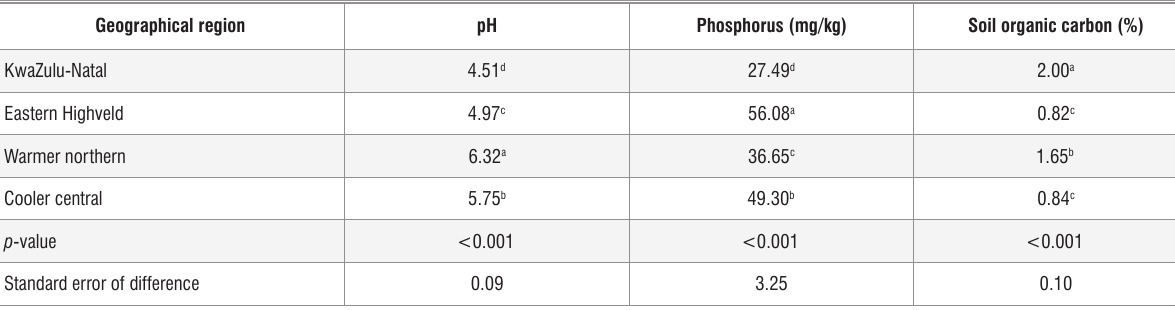
Table 5: Effects of geographical region on soil pH, phosphorus and organic carbon Geographical region pH Phosphorus (mg/kg) Soil organic carbon (%) KwaZulu-Natal Eastern Highveld Warmer